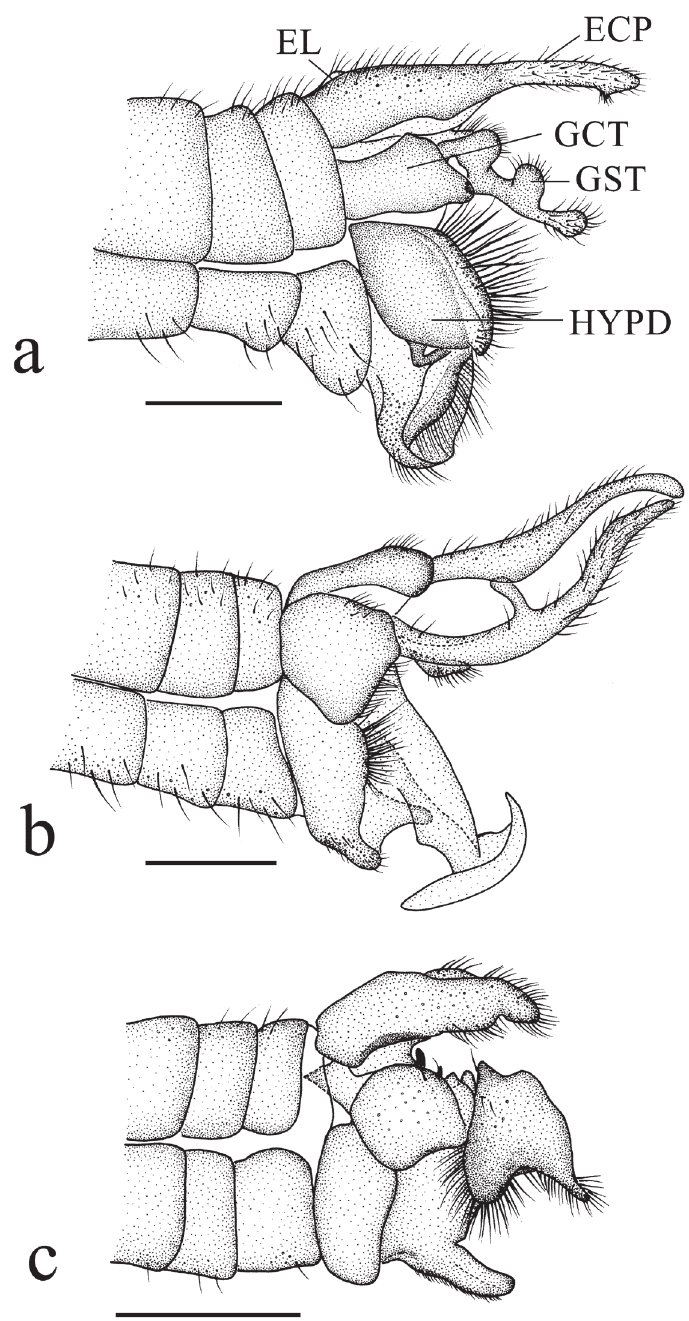
Figure 3. Male genitalia of new Ptychoptera species a P. hekouensis b P. longa c P. xiaohuangshana . Scale bars: 0.5 mm. (ECP = epandrial clasper, EL = epandrial lobe, GCT = gonocoxite, GST = gonostylus, HYPD =